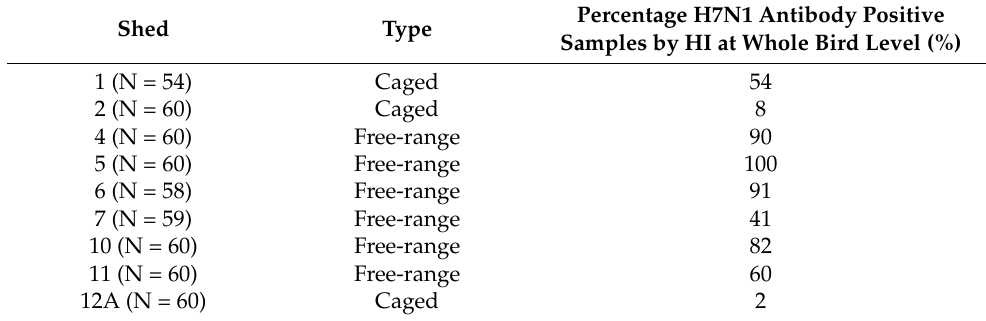
Table 6. HI results from Sample Set 3. The number of sera tested from each shed is provided in brackets.